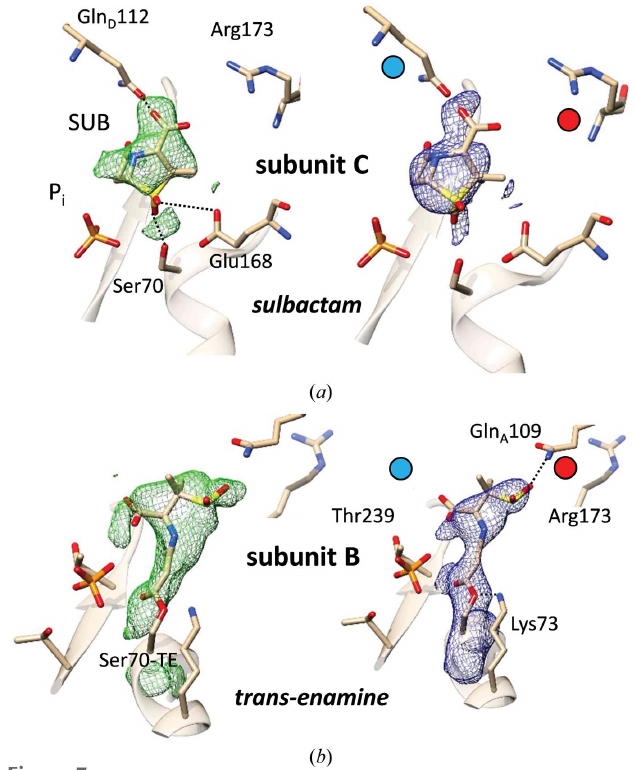
Figure 7 BlaC–SUB complexes at (cid:2) t m = 66 ms. ( a ) Active site in subunit C with noncovalently bound intact sulbactam; left side, DED iso map (contour: 3 (cid:6) ); right side, 2 mF o (cid:4) DF c map (contour: 1.7 (cid:6) ) after refinement. Close- by amino acids and the phosphate (P i ) are marked. ( b ) Active site in subunit B with trans -enamine bound to Ser70; left side, DED iso map (contour: 3 (cid:6) ); right side, 2 mF o (cid:4) DF c map (contour: 1.7 (cid:6) ) after refinement. Red and blue dots show important differences between the subunits. Gln112 from the adjacent subunit is not located close by and Arg173 is extended in subunit B , leaving subunit B more accessible to ligands and substrate.